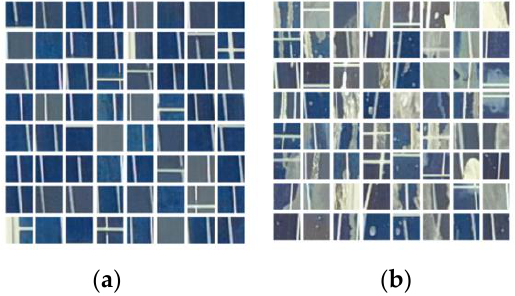
Figure 9. PV Segmentation images: ( a ) Positive sample; ( b ) Negative sample.